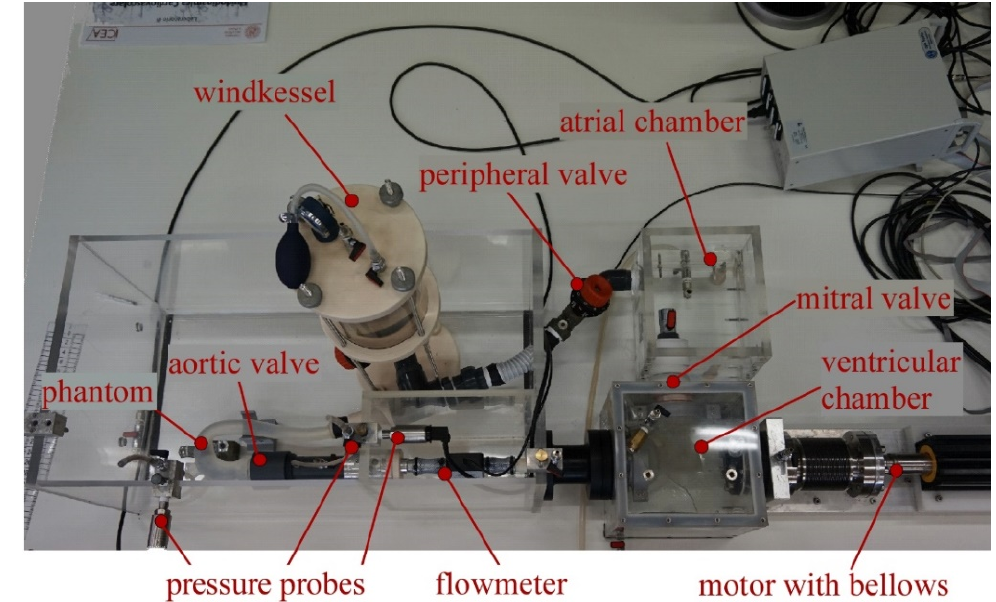
Figure 2. The Pulse Duplicator at the HER Lab. It is composed by the motor with the bellows, the left ventricle, the flowmeter, the aortic valve, the phantom of the aorta, the pressure probes, the systemic resistances, the Windkessel tank, the left atrium, and the mitral valve.